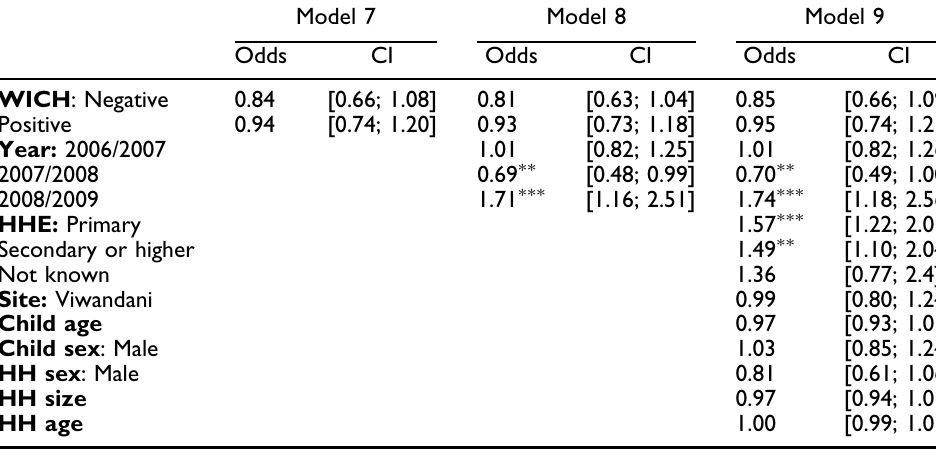
Table 5. Odds ratio from logistic regression models on shift to private informal schools Vs public only school (n = 1737; clusters =